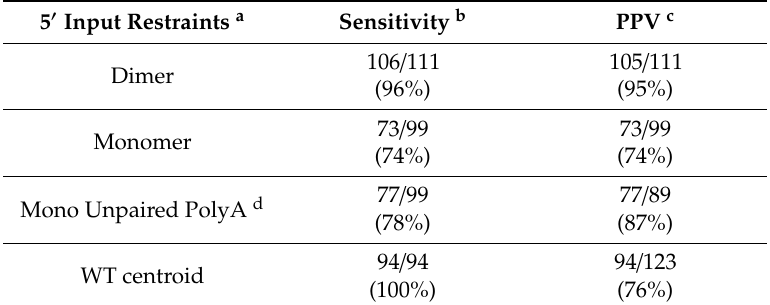
Table 1. SimRNA parsed nt–nt pairings of the experimentally-determined input restraints. 5 (cid:48) Input Restraints a Sensitivity b PPV